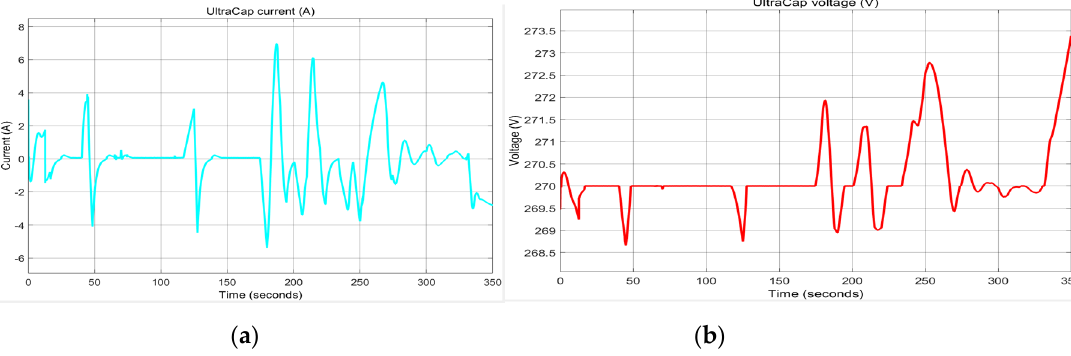
Figure 26. ( a ) UC current; ( b ) UC voltage.